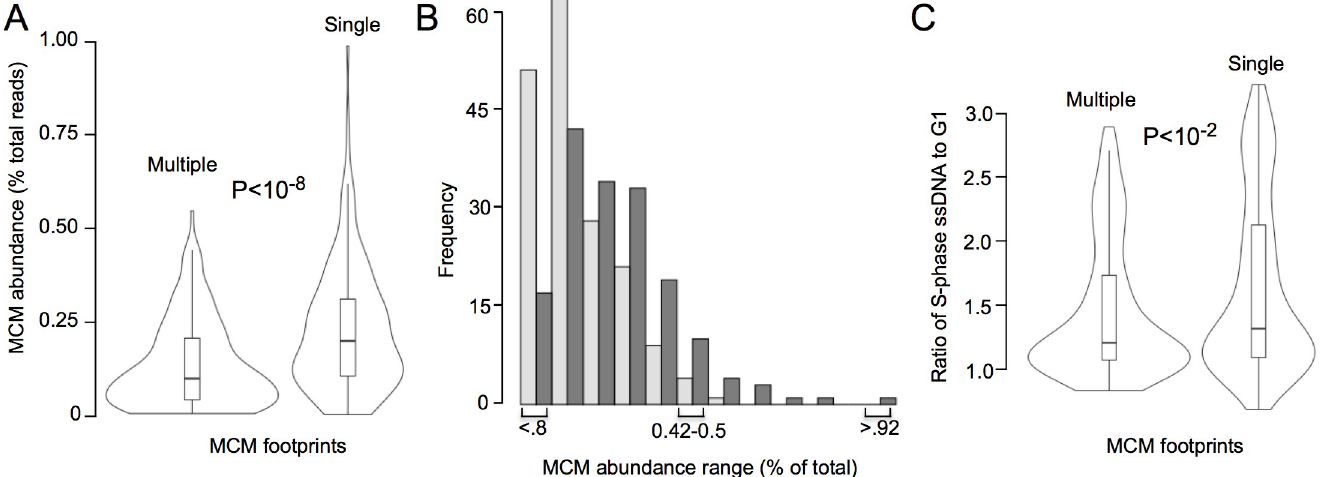
Fig 5. Comparison of Mcm2 abundance and replication activity at budding yeast origins that have single versus multiple Mcm signals. A. Total Mcm2-ChEC signal within 800 base pairs of the center of the origin is plotted according to whether at least 80% of that signal originates from within 60 base pairs of the peak of signal (right violin) or not (left violin), as described in the text. All fragment sizes are included in calculating MCM abundance. 341 origins listed in SGD were analyzed, with the two origins at the rDNA excluded. MCM abundance at the 165 origins with a single Mcm2-ChEC footprint was higher than that at the 176 origins with multiple footprints (p < 10 − 8 by two-tailed t test). B. Histograms showing distribution of Mcm2-ChEC signal for origins with single (dark gray) versus multiple (light gray) Mcm2-ChEC footprints. C. Origin activity, as measured by the presence of single-stranded DNA at origins 30 minutes after release of cells into S phase in HU [46], for origins with single versus multiple Mcm2-ChEC footprints (p = 0.003 by two-tailed t test).